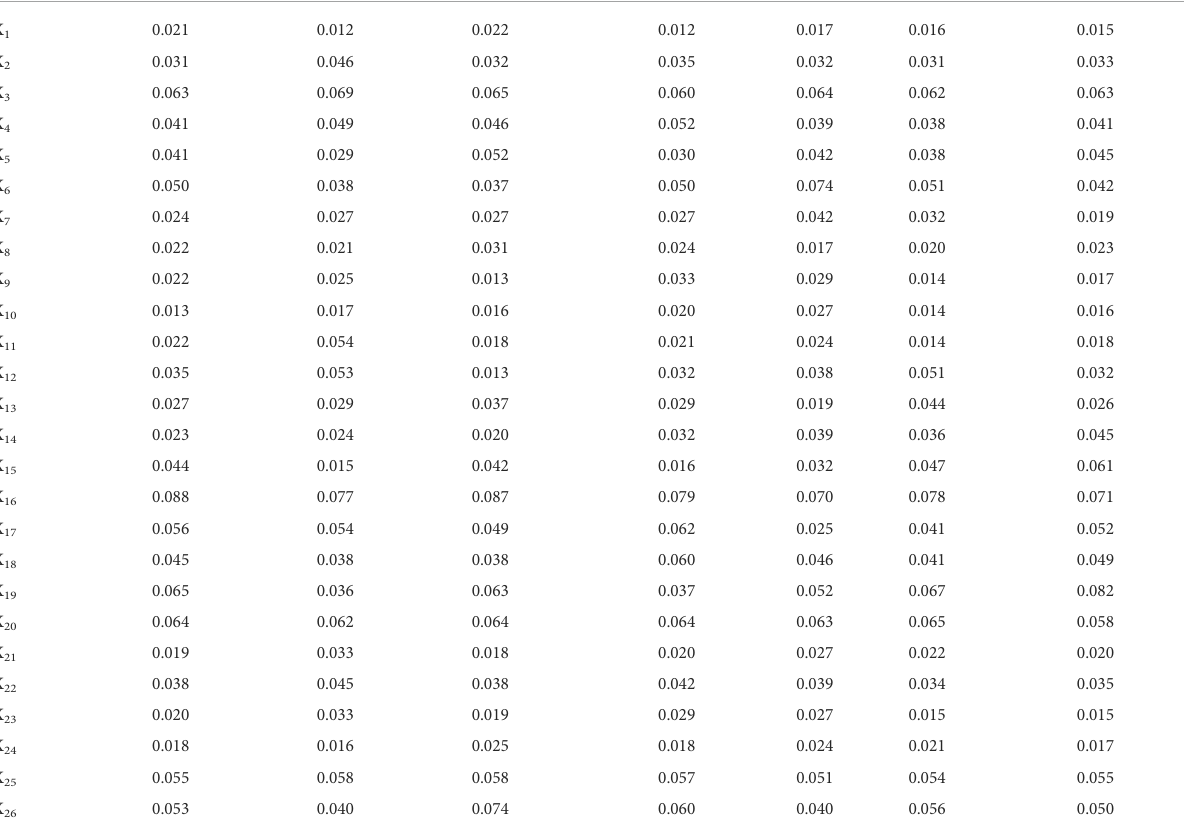
TABLE 4 Weights of indicators of farmland system vulnerability obtained by the combined weighting method.